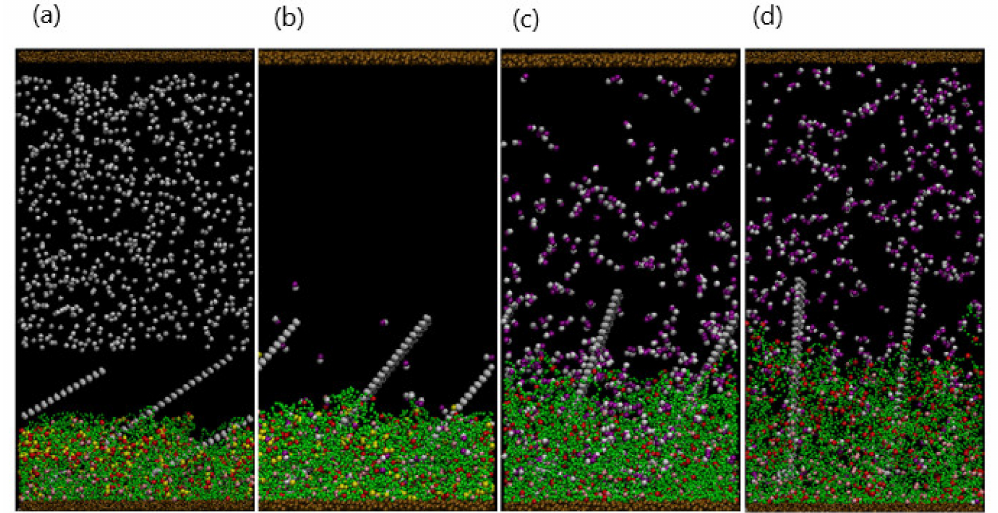
Figure 9. ( a – d ) Snapshots of the system after adding 700 EDTA particles at ( a ) t = 0, ( b ) t = 2 × 10 4 , ( c ) t = 2 × 10 5 , and ( d ) t = 5 × 10 6 , respectively. EDTA particles are removed for better visualization in ( b – d